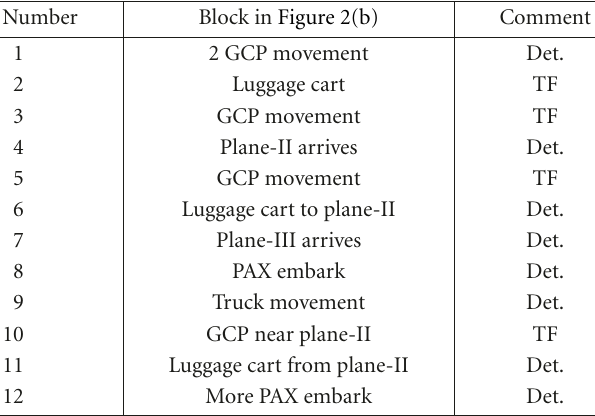
Table 4: TSA dataset: temporal segmentation of two blocks using the online BMS model. GCP = ground crew personnel, PAX = pas- sengers, Det. = segment detected, TF = tracking